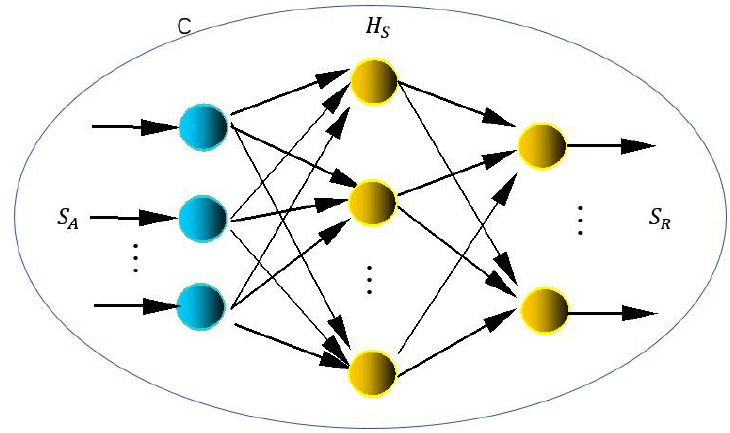
Figure 4. Simulation model of V-shaped electro-thermal actuator.